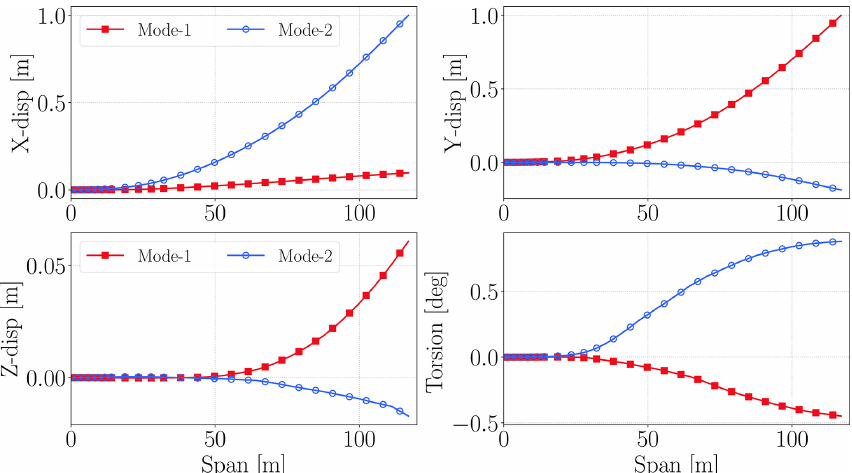
Figure 11. The lateral and torsional displacements of the first two mode shapes of the IEA 15MW reference wind turbine blade.